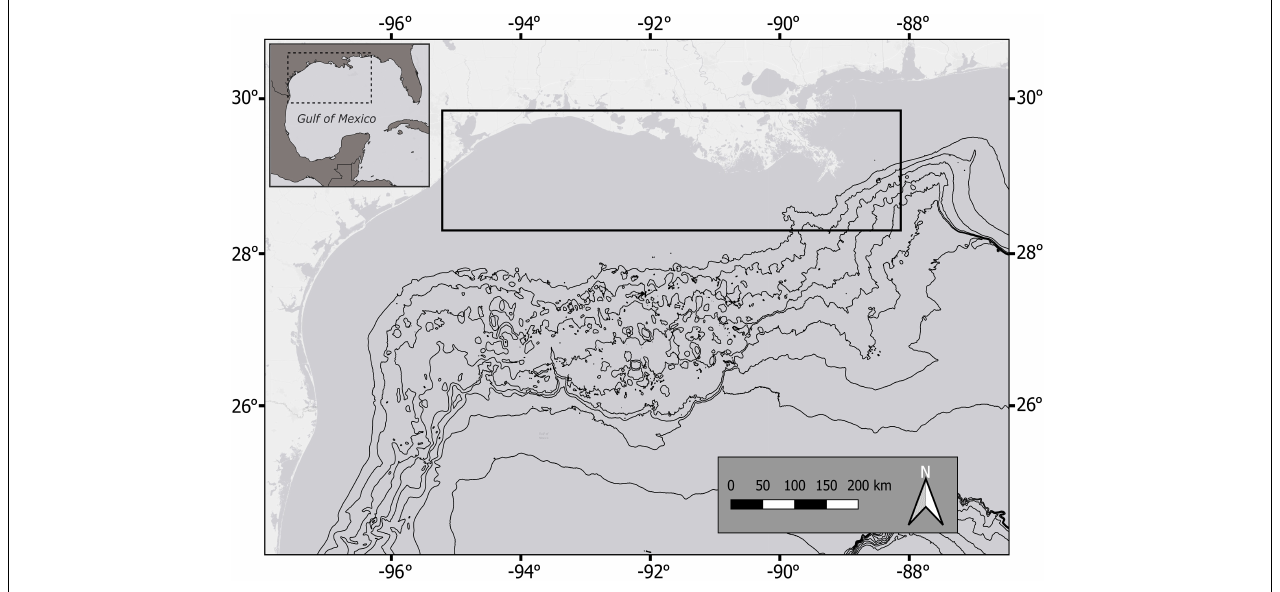
FIGURE 1 | Study area in the northwestern Gulf of Mexico (area within dashed square). The region where all sharks were collected is within the solid black square. Black contour lines begin at the continental shelf break (200 m